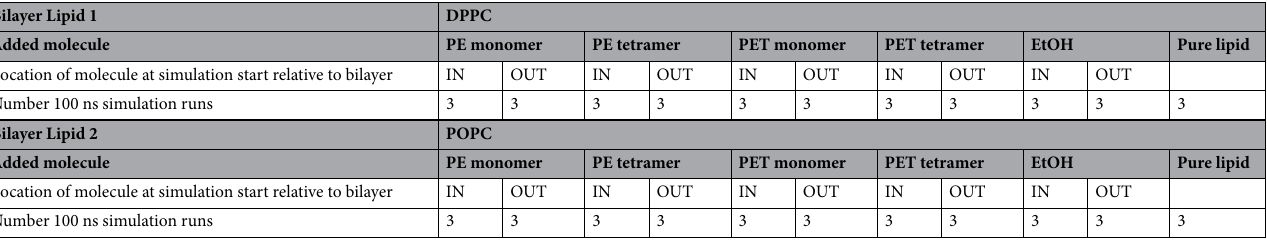
Table 1. Molecular dynamics simulation system